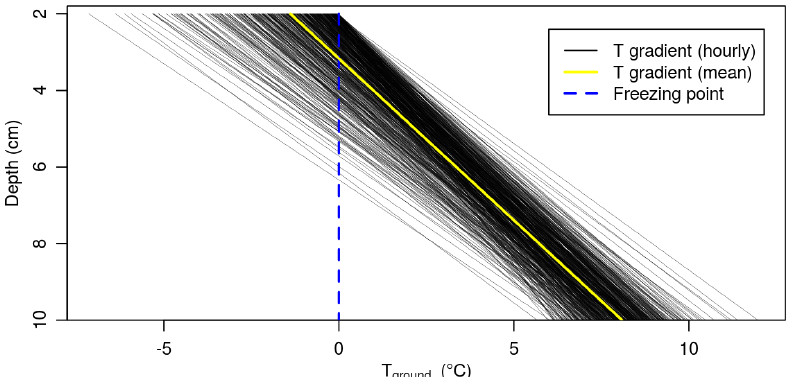
Figure D1. Estimated maximum frost penetration depth at logger location GT05 on the southern Sanetti Plateau assuming a linear ground temperature gradient between 2 and 10cm depth (i.e. between loggers GT05t and GT05m). Only hourly measurements in the period Febru- ary 2017 to January 2020 when T ground at 2cm depth was below 0 ◦ C were considered. The potential frost penetration depth is represented by the intersection of the blue and black lines. As the temperature profiles in the upper centimetres of the ground usually follow a nonlinear rather than a linear function, the actual frost penetration depth was probably less than the estimated